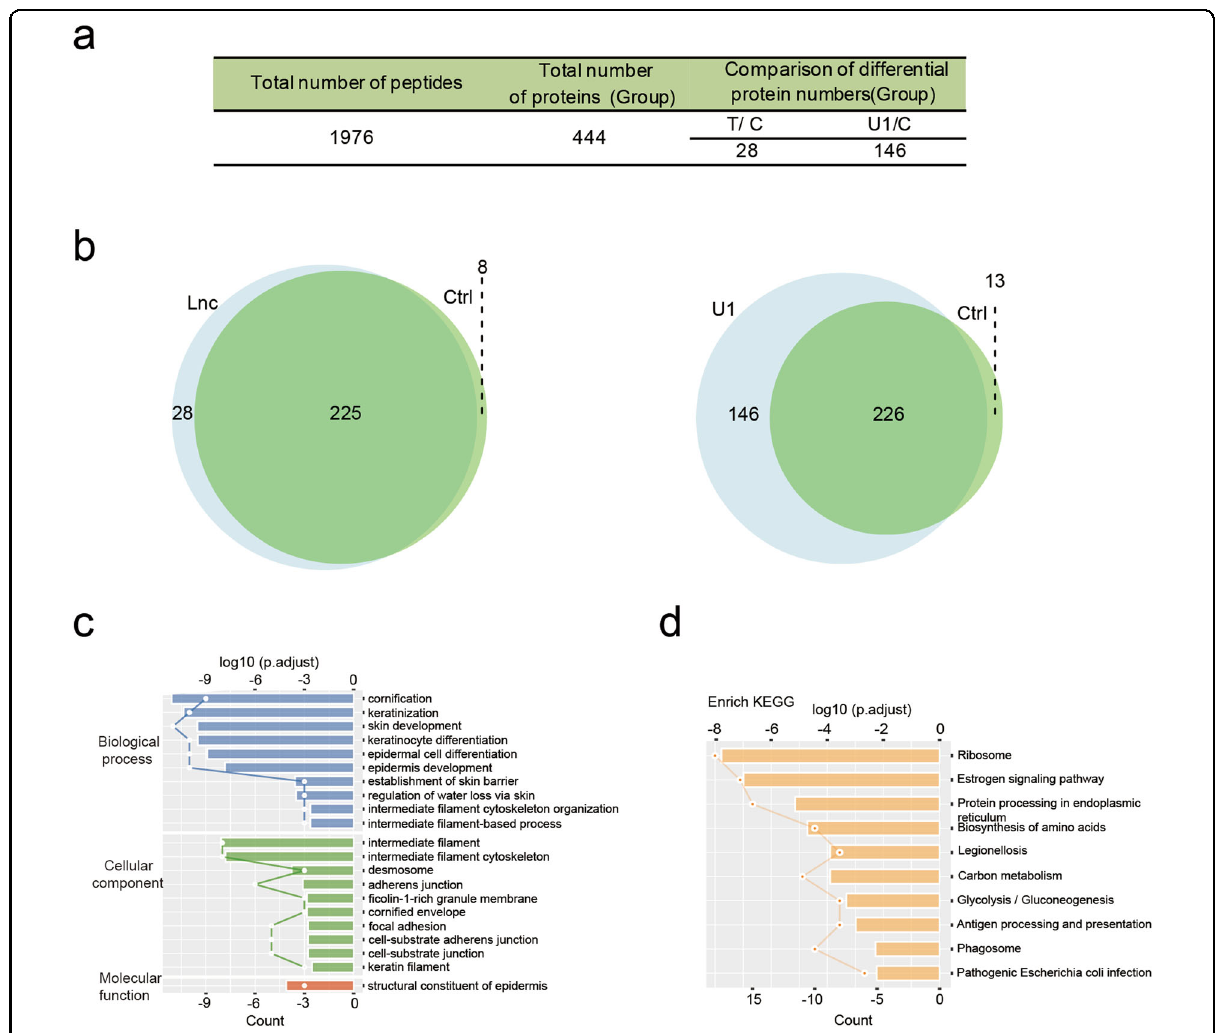
Fig. 4 Identi fi cation of endogenous protein partners associated with LYPLAL1-AS1 in hAMSCs. a Results from the ChIRP-MS assay. The experimental group (T, Test group, LYPLAL1-AS1 group), the negative control group (C), and the positive control group (U1) were individually analyzed quantitatively. b ChIRP-MS identi fi ed proteins that bind LYPLAL1-AS1 (left) and U1 (right); light blue indicates proteins that bind LYPLAL1- AS1 and U1, and light green indicates proteins that bind in the negative control group. c , d GO analysis ( c ) and KEGG analysis ( d ) of the identi fi ed proteins that directly bind to LYPLAL1-AS1. The y -axis shows the GO terms and the KEGG pathway names. The top x -axis shows the signi fi cance of the enrichment as log 10 ( P